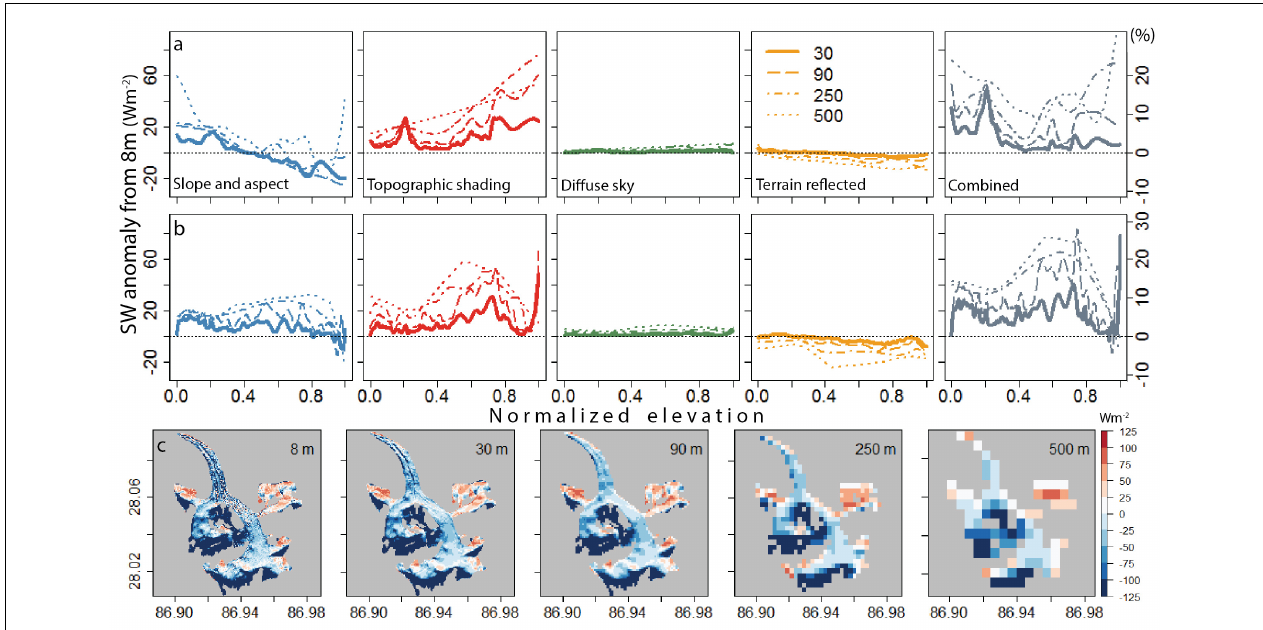
FIGURE 5 | Shortwave anomaly for 30-, 90-, 250-, and 500-m resolutions, relative to the 8-m HIMAT DEM, for the East Rongbuk Glacier ( a , top panels) and the Lumsamba Glacier ( b , middle panels) on March 21. The contribution of each terrain attribute to the modeled SW bias is shown at each downsampled DEM resolution, along with the combined bias from all terrain attributes. Overall, incident SW radiation is overestimated when resolution is coarsened. For both glaciers, the combined bias is most impacted by changes in modeled topographic shading and slope/aspect, while the change from diffuse sky and terrain-reflected are smaller in magnitude and vary less at different spatial resolutions. This holds true for all 10 glaciers in this study. Panel (c) shows the combined change in irradiance due to all terrain attributes on this day at each downsampled resolution for East Rongbuk Glacier. The SW anomaly is the difference between the change in irradiance determined at each coarse DEM resolution relative to the change in irradiance calculated with the 8-m HIMAT